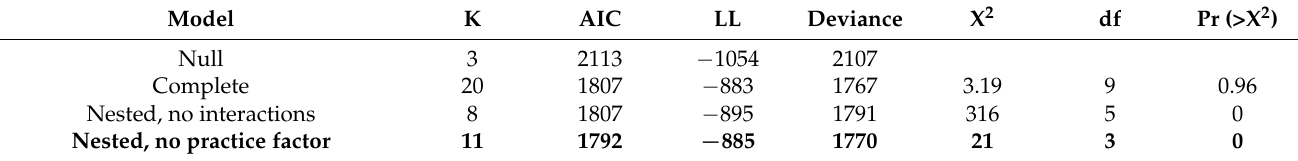
Table 3. Model 2, analysis of variance for the NDVI mixed-effects models. The optimal model (“Nested no practice”, shown in boldface) was selected according to the lowest AIC and greatest log-likelihood (K: number of parameters; LL: log-likelihood; df: degrees of